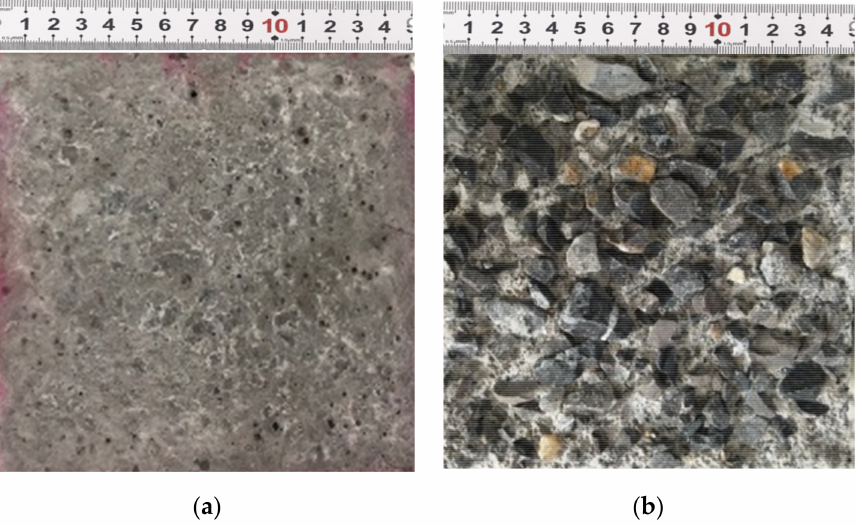
Figure 1. Two kinds of interface in sectional dimension of 150 mm × 150 mm: ( a ) original surface; ( b ) washed rough surface.